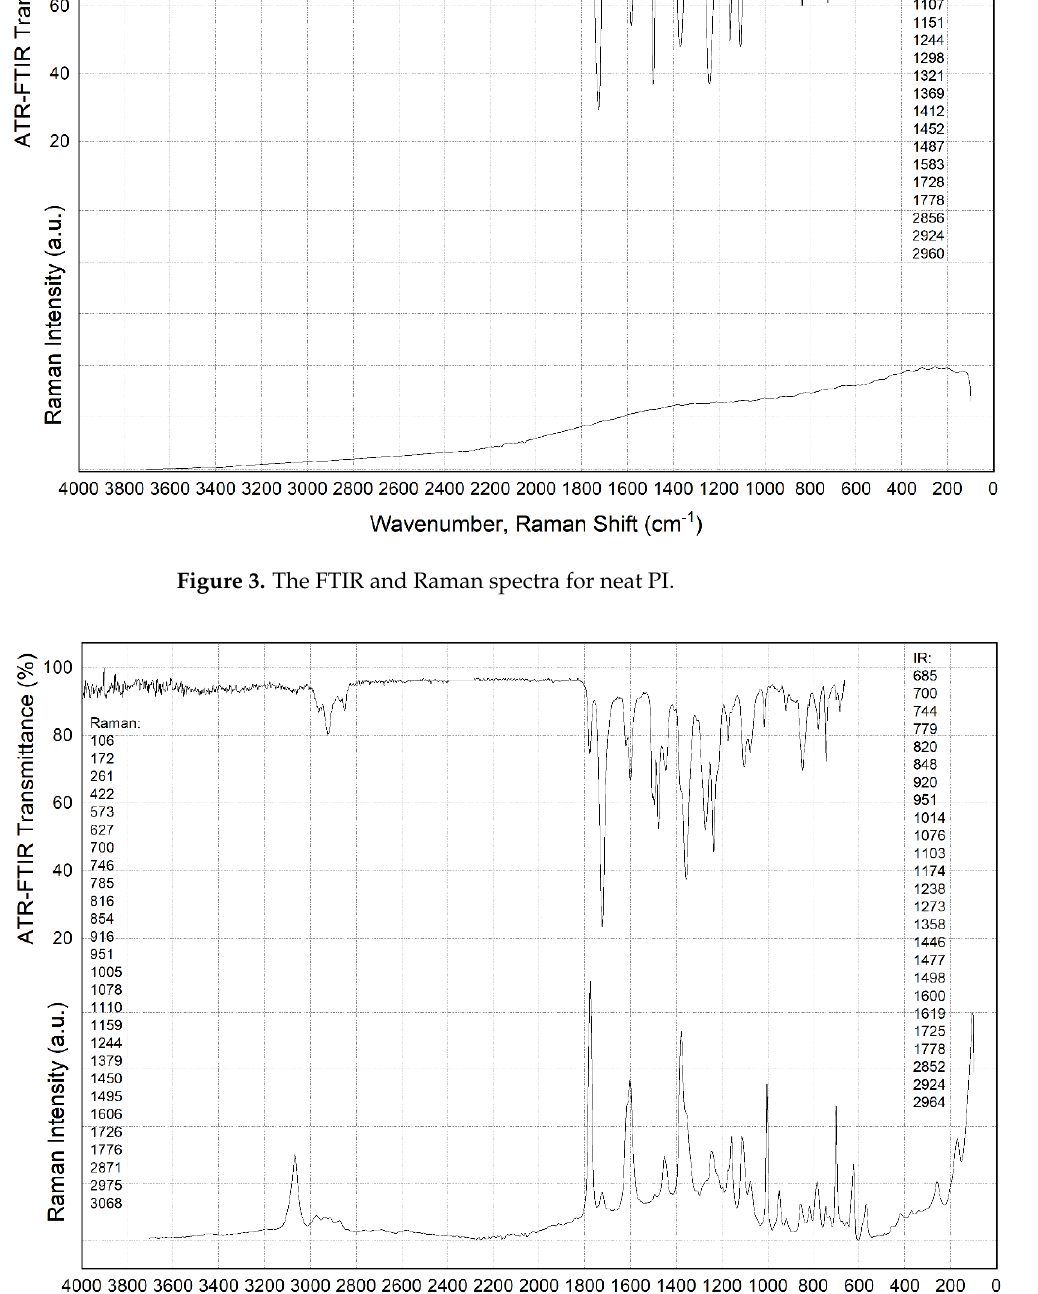
Figure 4. The FTIR and Raman spectra for the neat PEI.